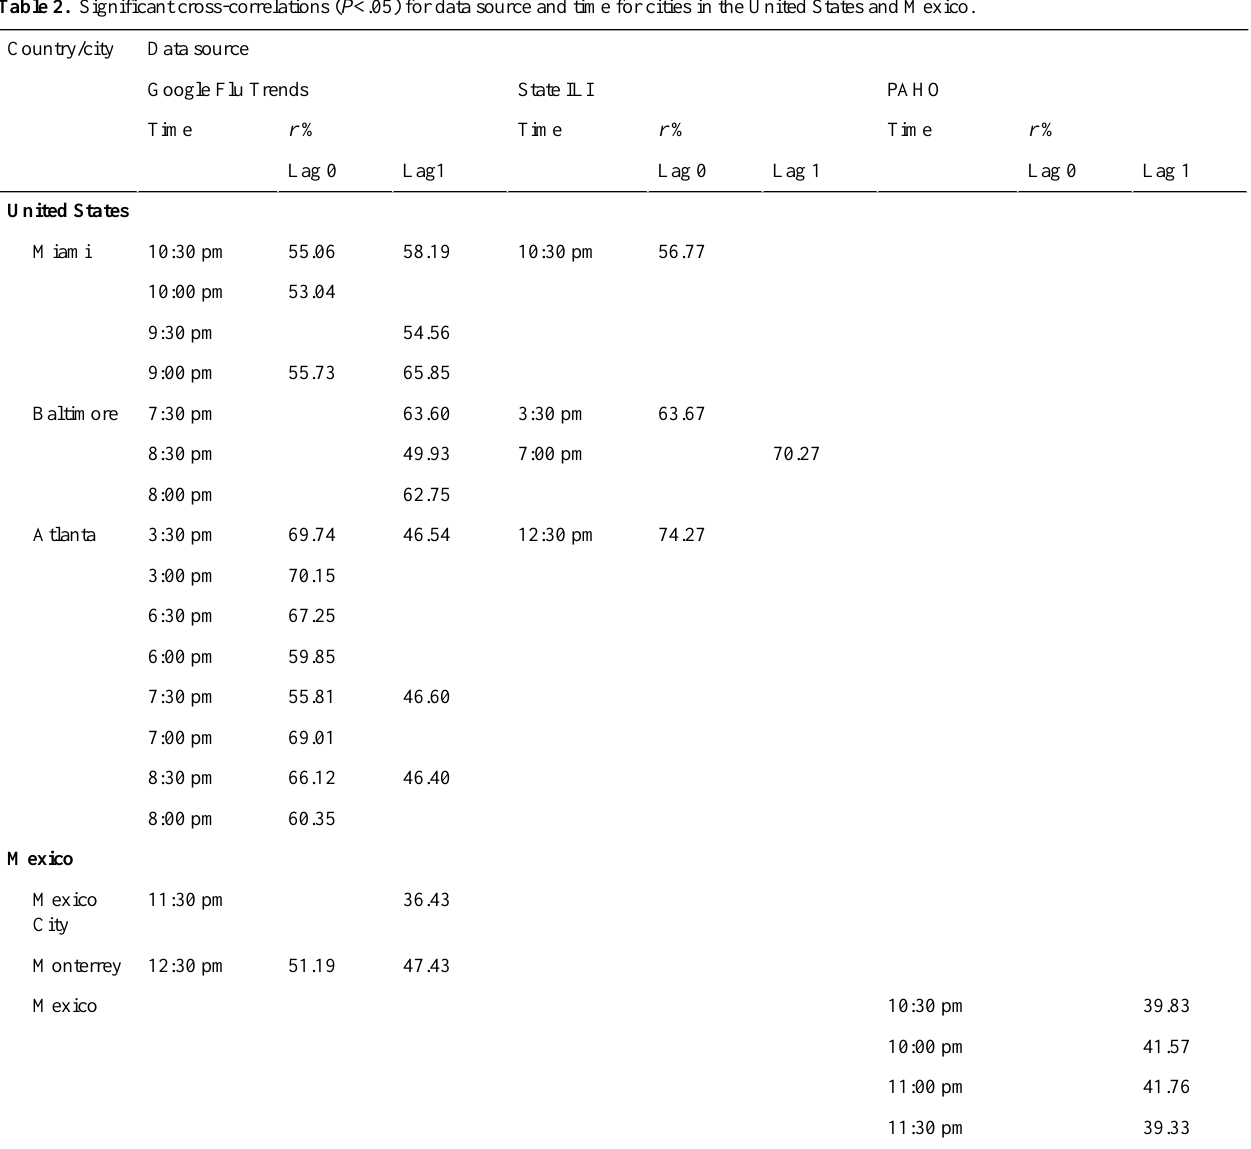
Table 2. Significant cross-correlations ( P <.05) for data source and time for cities in the United States and Mexico. Data